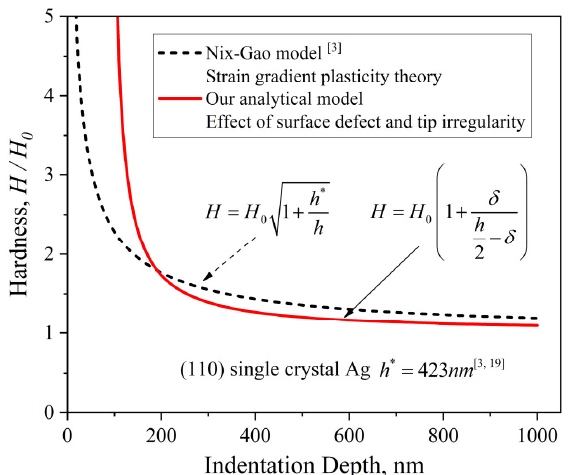
Figure 5. Comparison of our model and the conventional Nix–Gao model. Both models are related to their own characteristic constants respectively. Here, it simply takes h * /  =